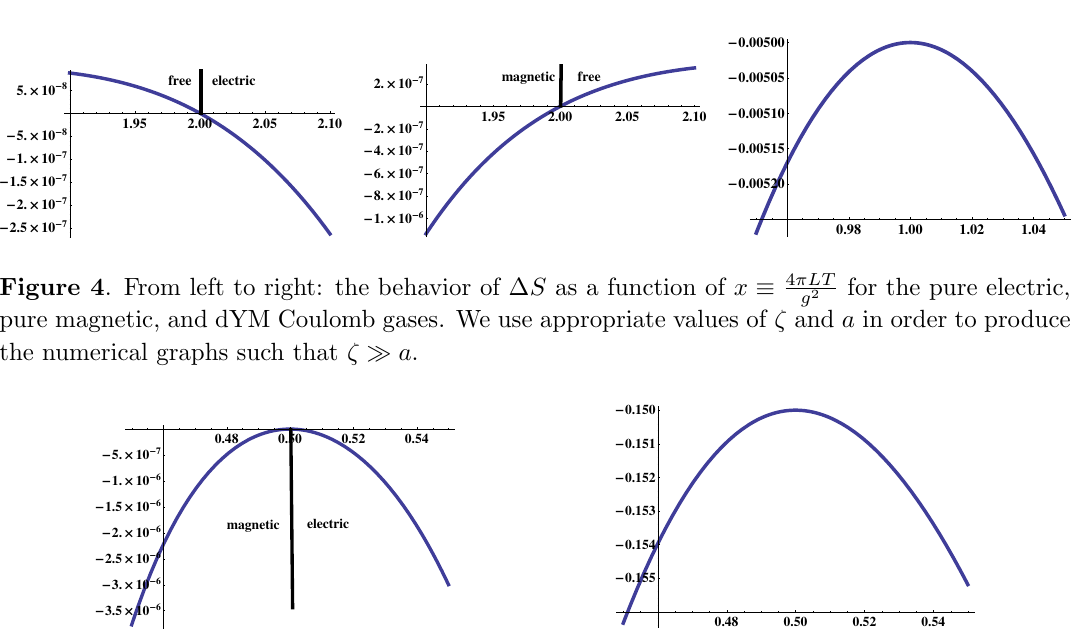
Figure 5 . The behavior of (cid:1) S as a function of x a maximum at T c = g 2 . In addition (cid:1) S = 0 exactly at T c , which indicates that the theory is 8 (cid:25)L Gaussian at the transition point. Right: (cid:1) S of dYM(F).